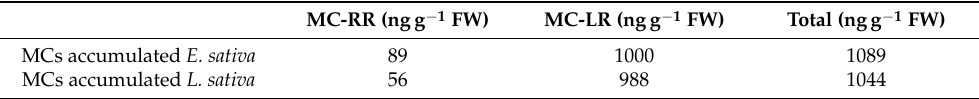
Figure 2. HPLC profile of extracellular (3) and intracellular (4) MCs produced from Microcystis aeruginosa isolated from some of the water sources used in irrigation of crop plants in Sohag district. Table 3. Concentrations of microcystin (MC-LR and MC-RR) accumulated in edible parts of two plants ( Eruca sativa and Lactuca sativa